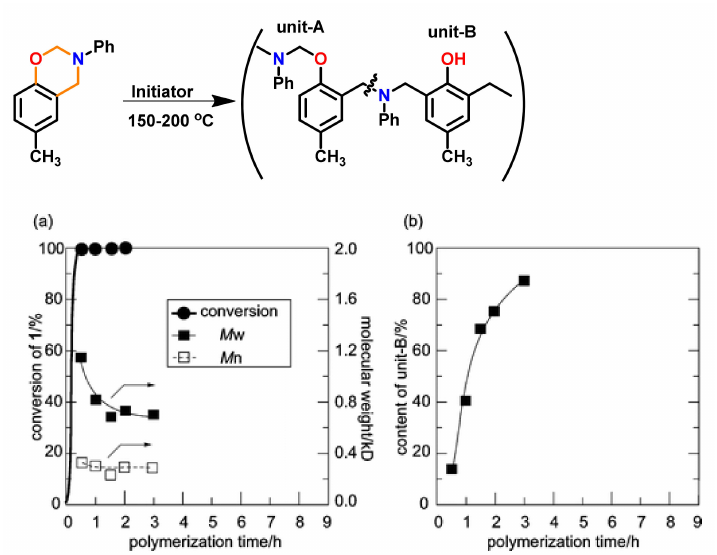
Figure 45. ( a ) Time-dependences of conversion of p C-a and molecular weights of the polymer structure and ( b ) content of unit-B in poly( p C-a) in the presence of 1 mol% TsOH at 180 ◦ C [269]. Copyright 2008. Reproduced with permission from American Chemical Society.